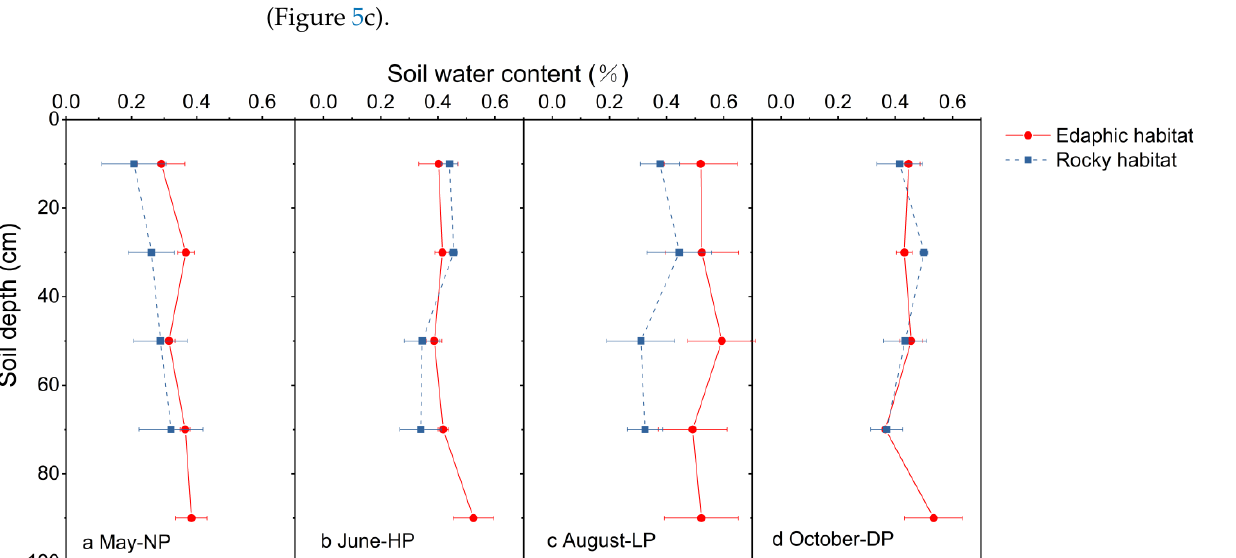
( a ) May sampling; ( b ) June sampling; ( c ) August sampling; ( d ) October sampling).